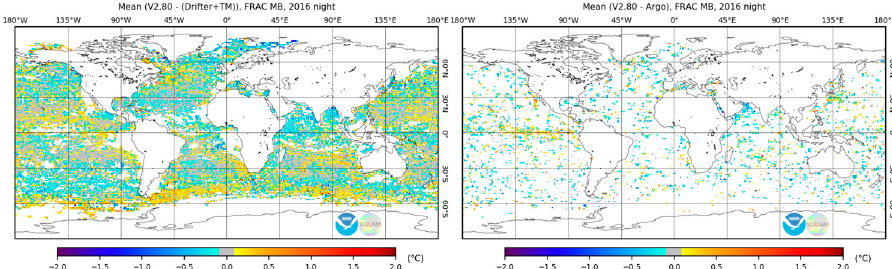
Figure 6. Nighttime yearly aggregated maps of Metop-B GR – in situ SSTs in 2016, for two in situ references: ( left ) D+TM; ( right ) AF.